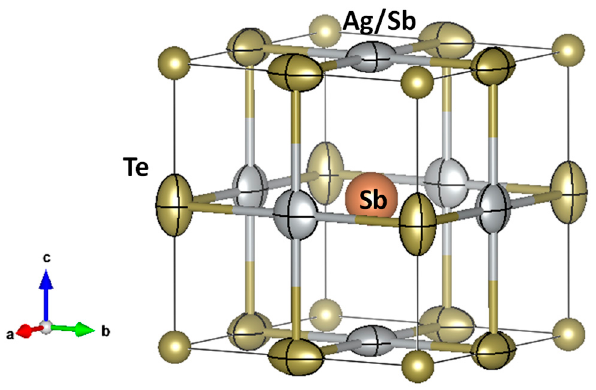
Figure 2. Crystal structure of AgSbTe 2, defined in the Pm 3 m space group. The characteristic shape of the ellipsoids (elongated for Te1 and flattened for Ag/Sb2) are highlighted. Table 1. NPD experimental parameters of AgSbTe 2 at room temperature.